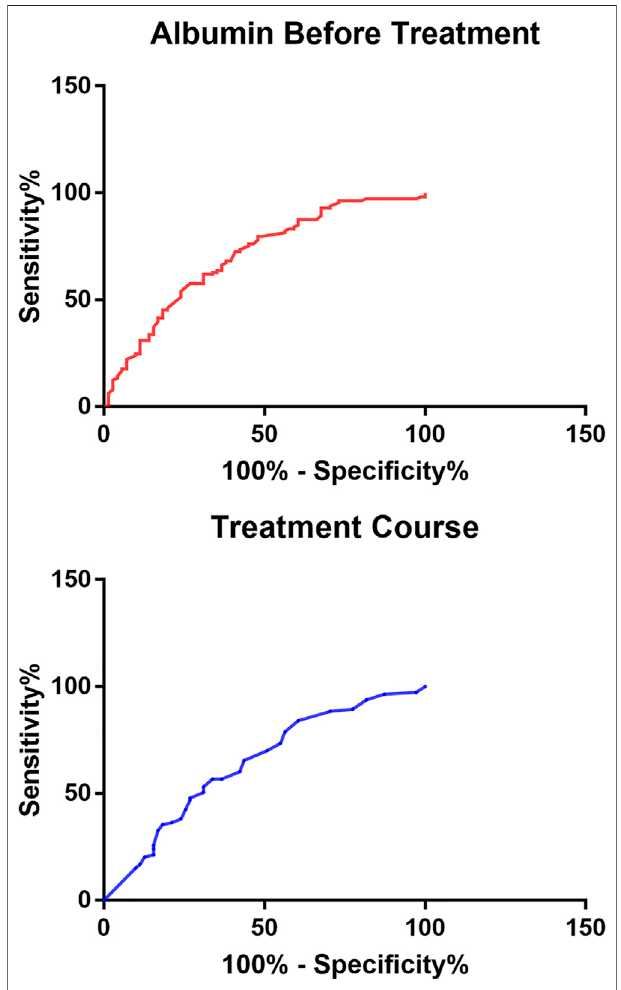
FIGURE 3 | ROC curve of mitigation-related factors on mitigation